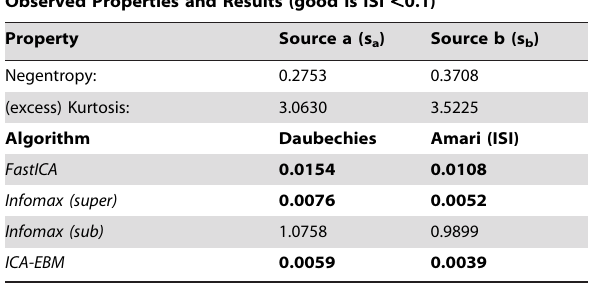
Table 2. Tabulated results for the so-called [8] ICA ‘‘promotional material.’’